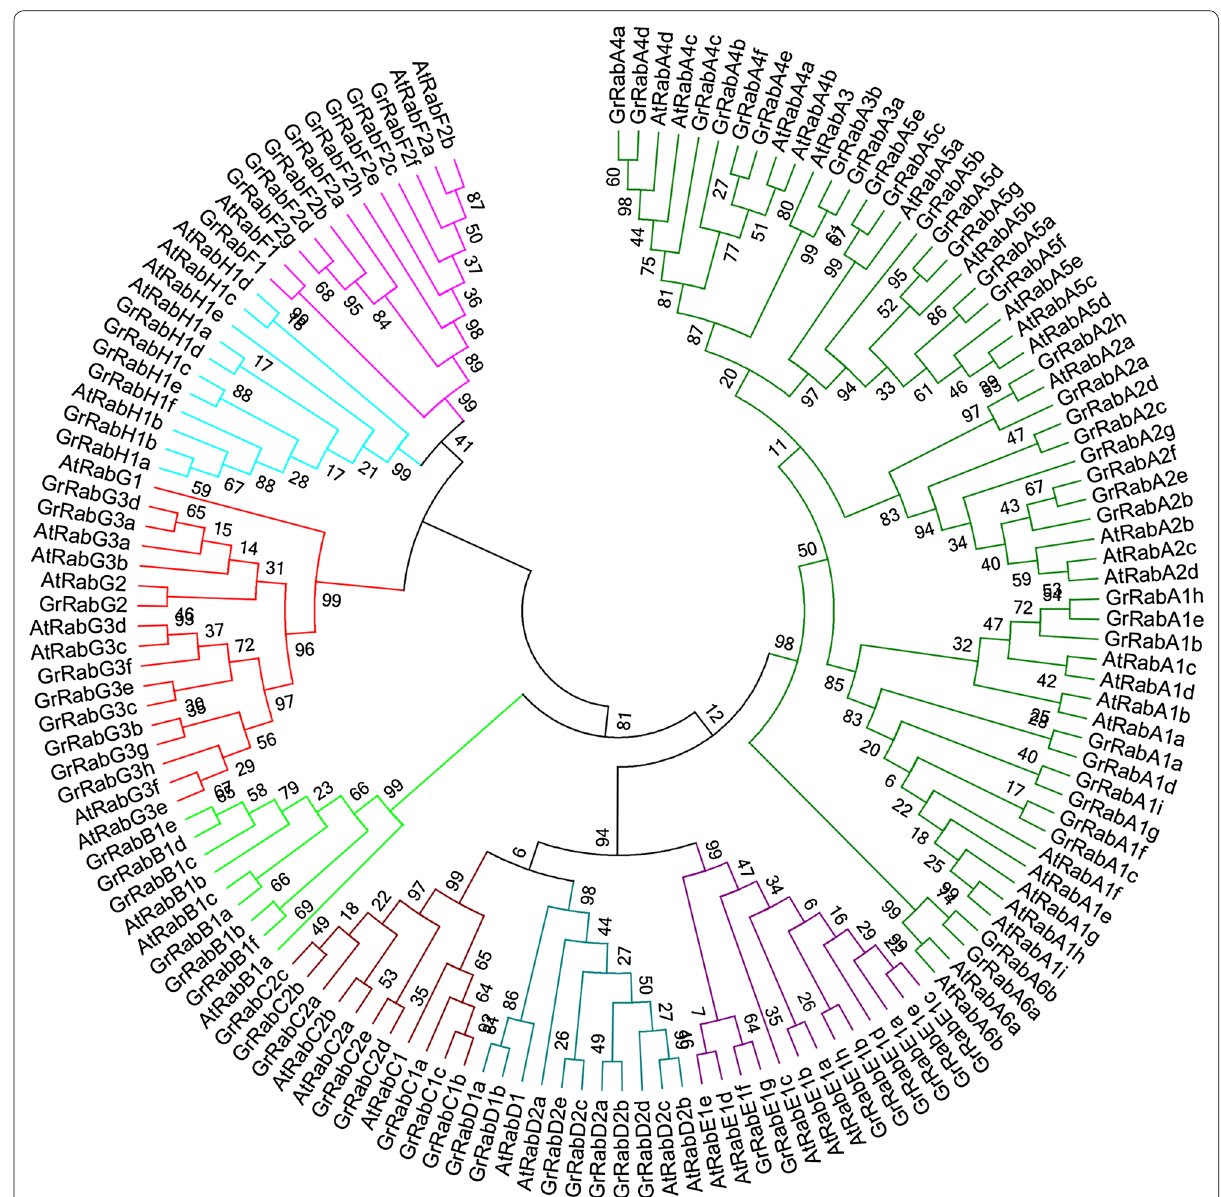
Fig. 1 Phylogenetic relationships of Rab family members between G. raimondii and Arabidopsis . The multiple alignment of the conserved Rab family domain between G. raimondii and Arabidopsis were constructed with Clustal X (version 2.0). Phylogenetic tree was generated using the maximum likelihood method under WAG model in MEGA v5.2, and the reliability of interior branches was assessed with 1000 bootstrap resamplings